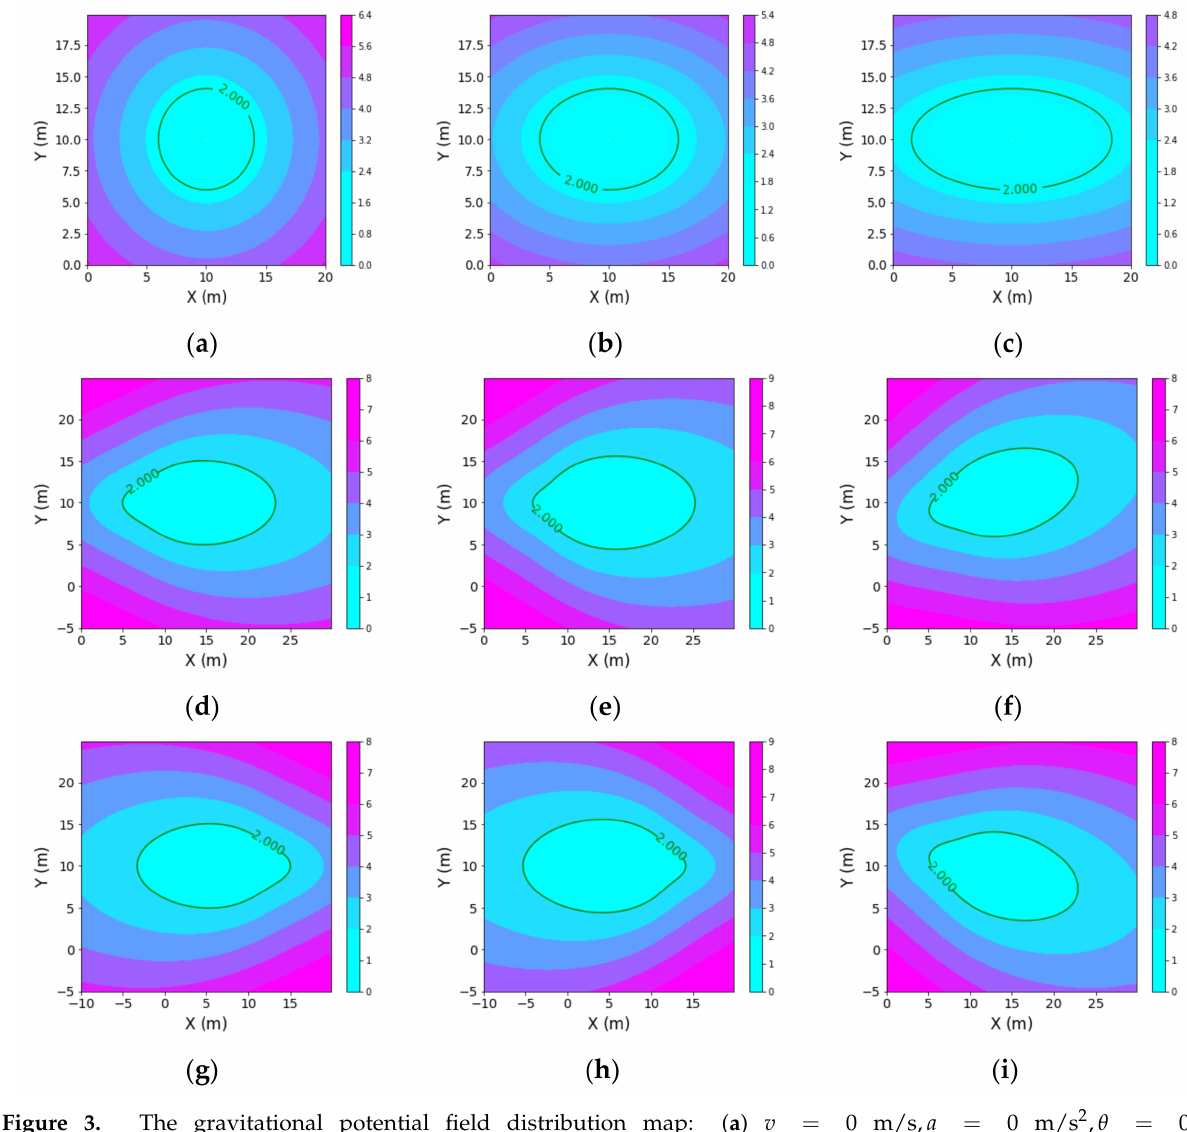
Figure 3. The gravitational potential field distribution map: ( a ) v = 0 m/s, a = 0 m/s 2 , θ = 0 ◦ ; ( b ) v = 5 m/s,a = 0 m / s 2 , θ = 0 ◦ ; ( c ) v = 10 m/s, a = 0 m/s 2 , θ = 0 ◦ ; ( d ) v = 10 m/s, a = 1.5 m/s 2 , θ = 0 ◦ ; ( e ) v = 10 m/s, a = 2 m/s 2 , θ = 0 ◦ ; ( f ) v = 10 m/s, a = 1.5 m/s 2 , θ = 15 ◦ ; ( g ) v = 10 m/s, a = − 1.5 m/s 2 , θ = 0 ◦ ; ( h ) v = 10 m/s, a = − 2 m/s 2 , θ = 0 ◦ ; ( i ) v = 10 m/s, a = 1.5 m/s 2 , θ = − 15 ◦